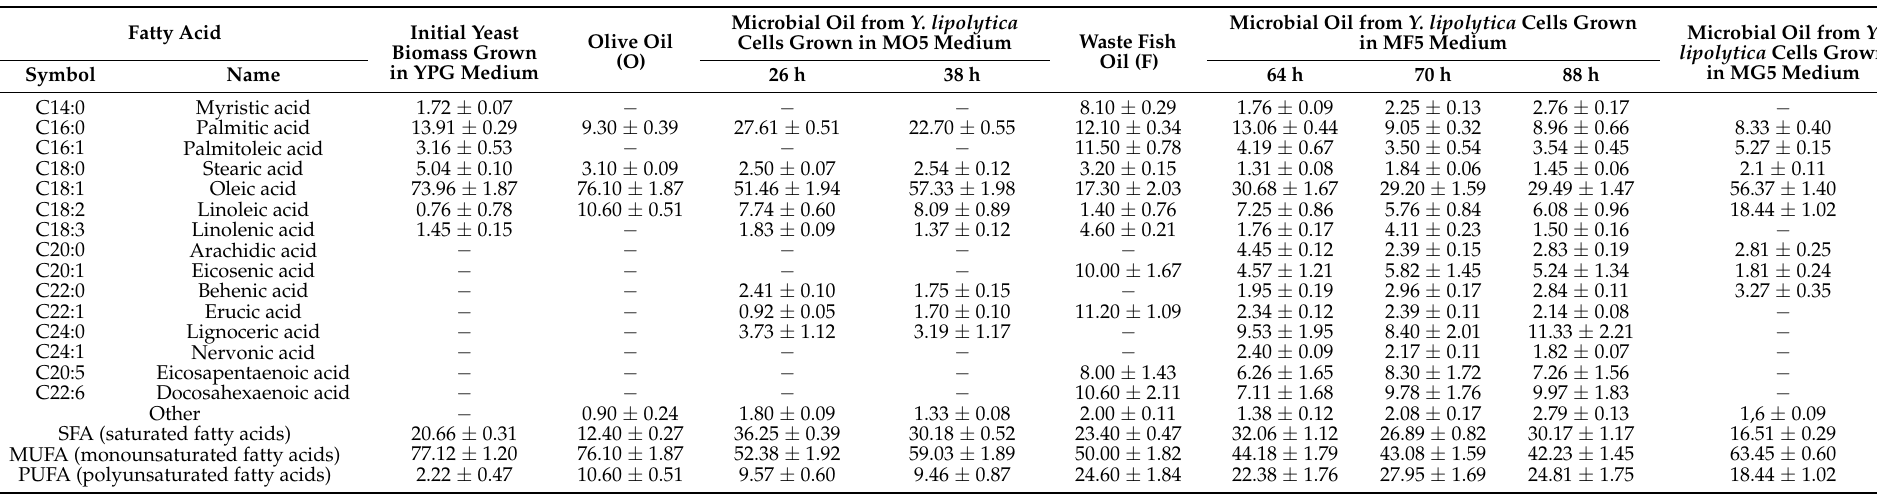
Table 2. Profile of fatty acids in carbon sources (waste fish oil, olive oil), initial yeast biomass grown in YPG medium and microbial oil extracted from yeast cells grown in MF5, MO5 and MG7 medium (content of fatty acids in relations to total fatty acids concentration,